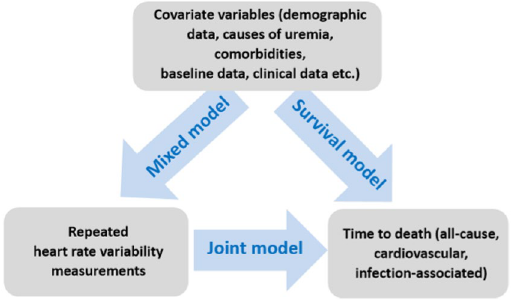
Figure 1. The diagrammatical representation of the joint